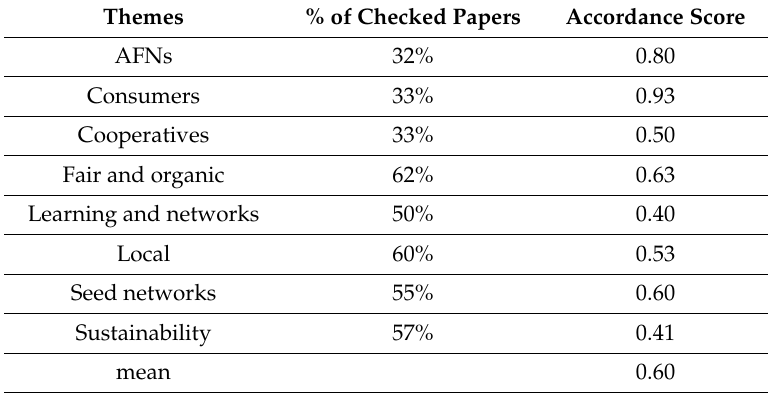
Table A2. Inter-coder-reliability: evaluation of accordance of the content analysis